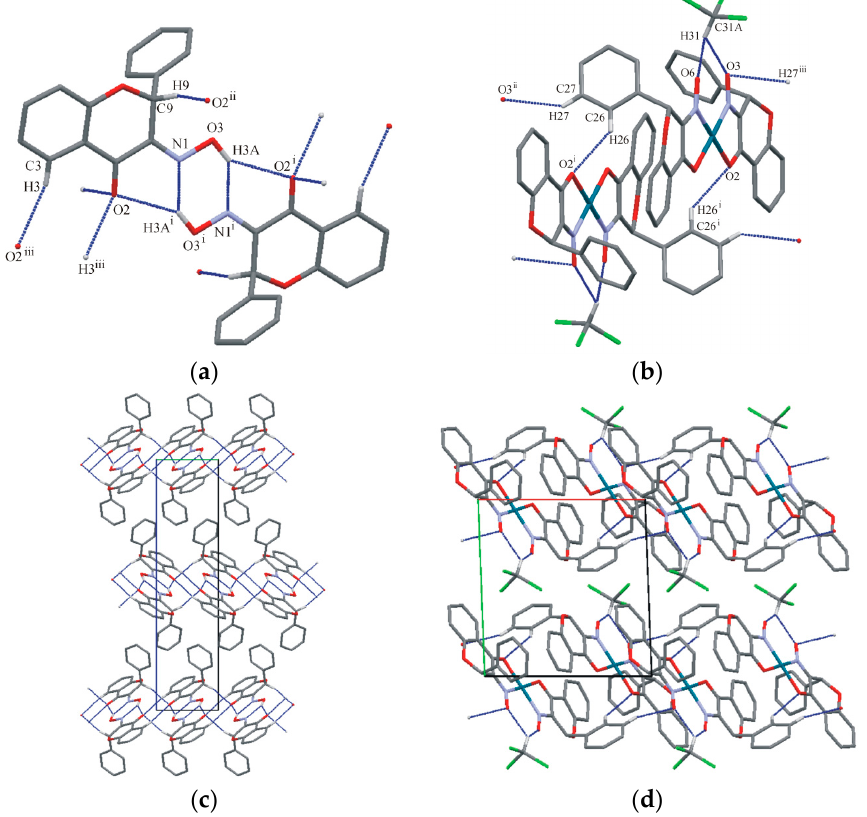
Figure 2. The schemes of intermolecular interactions of free-ligand ( 1 ) ( a ) and its Pd(II)-complex ( 2 ) ( b ). Crystal packing of 1 along a axis showing the organization of molecular layers ab ( c ) and chains of supramolecular dimers in structure 2 viewing along c axis ( d ). Symmetry codes: for 1 : (i) 1 − x , 1 − y , − z ; (ii) x , y − 1, z ; and (iii) − x , 2 − y , − z . Symmetry codes for 2 : (i) 1 − x , − y , 1 − z ; (ii) x + 1, y , z ; and (iii) x − 1, y , z .